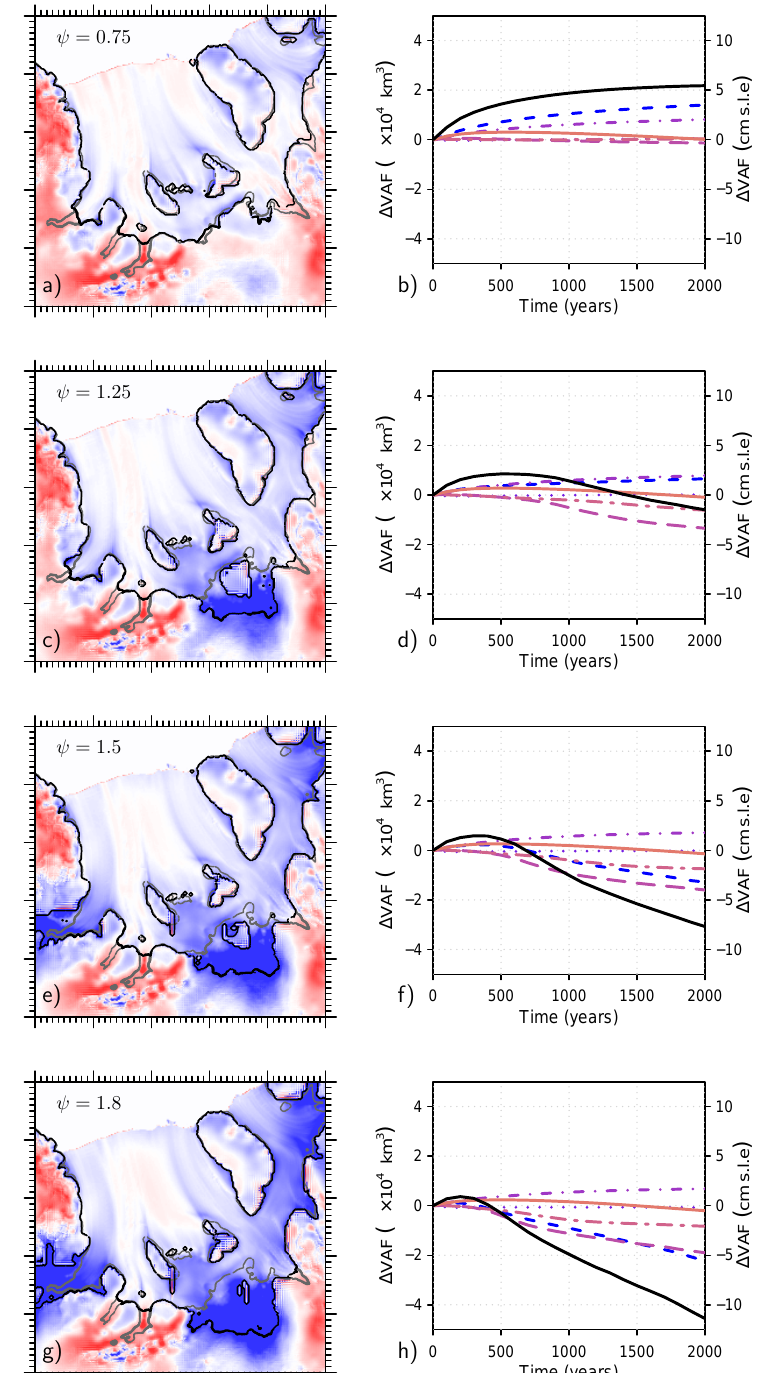
Figure 6. Left-hand side (a, c, e, g) panels are plan-view maps showing changes in ice thickness (colour scale) and grounding line position (grey: start; black: end) over 2000-year model runs. Right-hand side (b, d, f, h) panels are plots of cumulative volume above flotation change against time for each of the ice stream catchments for the same experiment. In each experiment the sub-shelf accumulation/melt-rate field has been multiplied by a factor ψ : ( a and b ) ψ = 0 . 75, ( c and d ) ψ = 1 . 25, ( e and f ) ψ = 1 . 5, and ( g and h ) ψ = 1 . 8. The colour scale for the volume changes in (a) , (c) , (e) and (g) is the same as for Fig. 5a, and the code for plot lines in (b) , (d) , (f) and (h) is given in Fig.